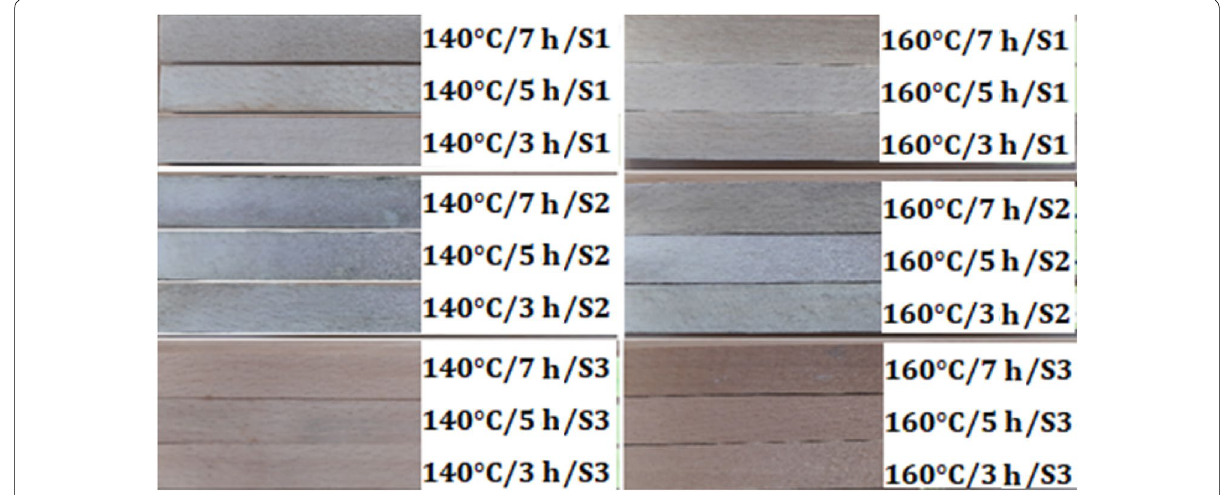
Fig. 7 Heat-treated beech samples after bleaching